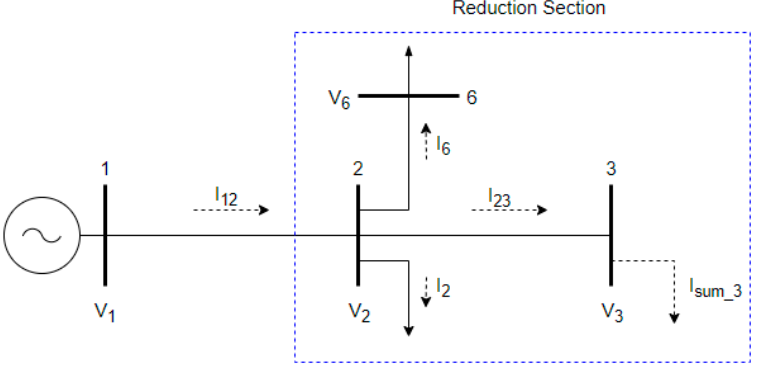
Figure 2. Single line diagram of reduction section 1 .